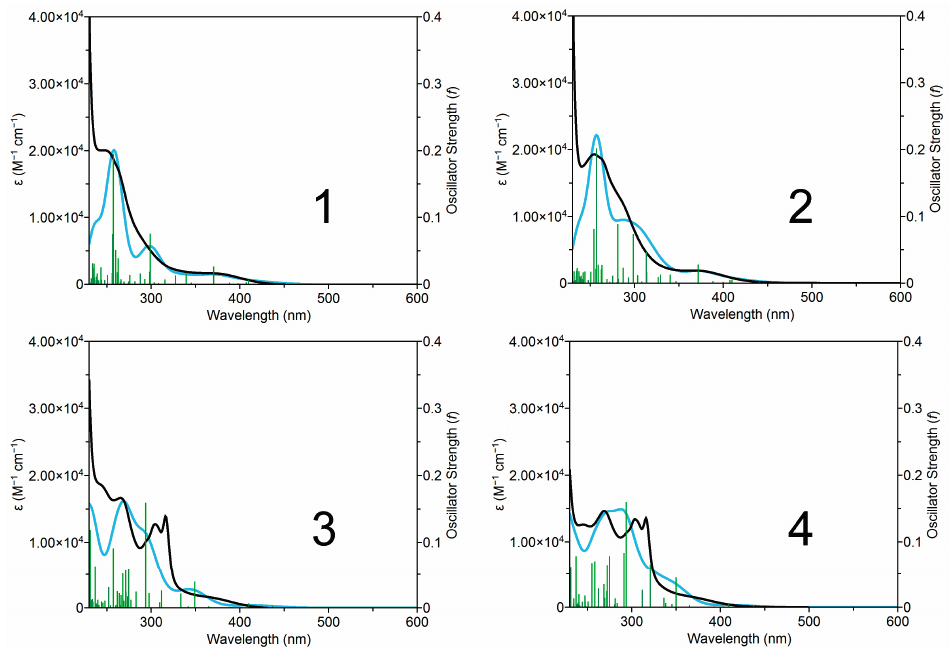
Figure 5. Experimental (black) and theoretical (light blue) UV-Vis spectra of 1 – 4 in aqueous solution. Calculated singlet-singlet electronic transitions are shown as vertical bars with heights equal to their oscillator strength. GaussSum 2.2.5 [10] was used to simulate the theoretical UV-Vis spectra (FWHM = 3000 cm − 1